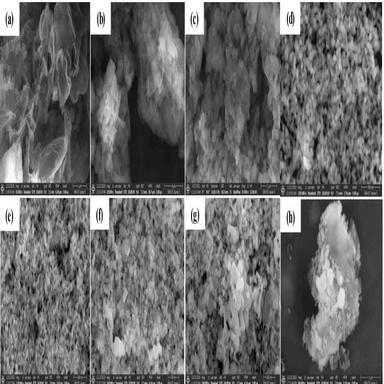
FE-SEM images of the (a) g-C3N4, (b) EG-g-C3N4, (c) H-EG-g-C3N4, (d) Bi2Ti2O7, (e) Cu-Bi2Ti2O7, (f) Fe-Bi2Ti2O7, (g) Cu, Fe-Bi2Ti2O7 and (h) Cu, Fe-BTO/EGCN.